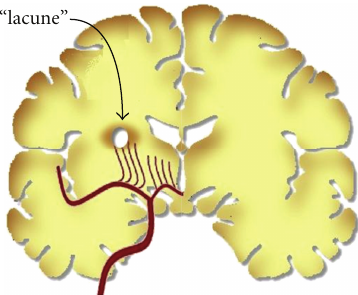
Figure 2: An illustration of coronal cross section of the brain showing a small cavity termed a “lacune” within the subcortical white matter and in the territory of perforating